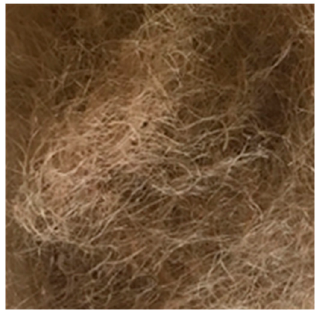
Figure 1. Jute fibres (not to scale).